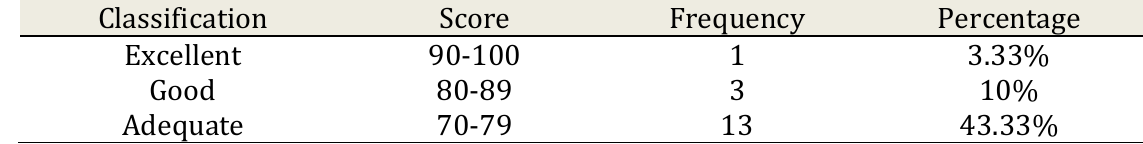
Table 4. T he students’ post -test result in control